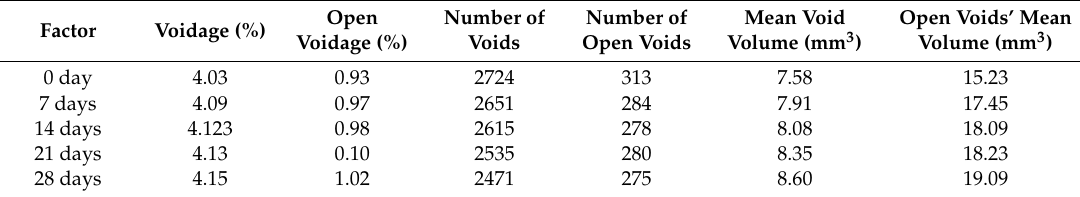
Table 12. Void Calculation Data for the AC3 specimen (Under Dry and Water Conditions).